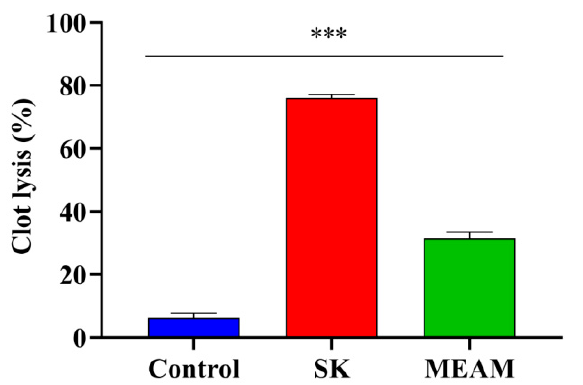
Figure 2. Percentages of clot lysis of in vitro thrombolytic activity of methanol extract of A. montanum (MEAM) and standard drug streptokinase (SK). Values are presented as mean ± S.E.M. (n = 5); *** p < 0.001 were statistically significant in comparison to control (Dunnett’s test).